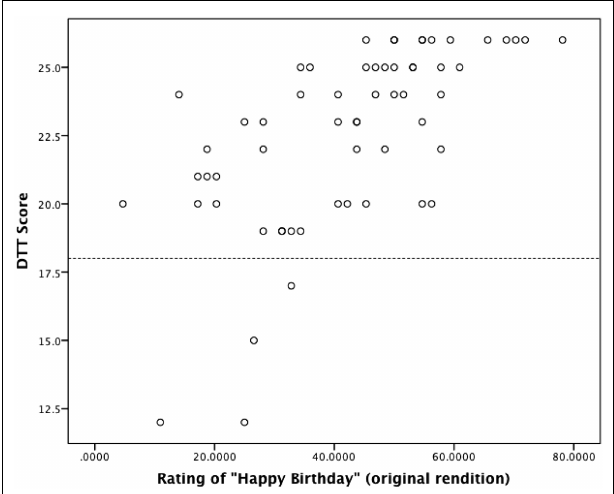
FIGURE 3 | Relationship between performance on the distorted tunes test (DTT) and ratings of singing abilities. Scores below the dashed line are in the range of amusia ( ≤ 18).There was a strong association between musical perception abilities (DTT) and production abilities (singing; ρ = 0.684, p <